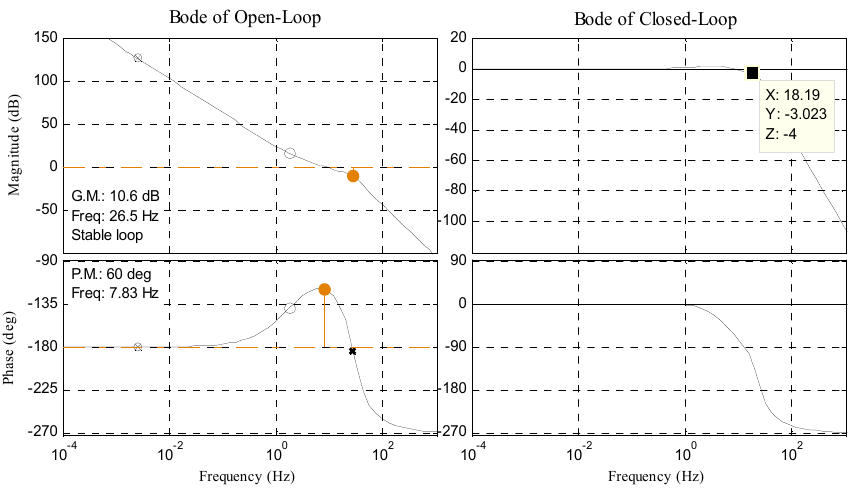
Figure 3. Bode diagram of open position-loop and closed position-loop in no-delay situation.